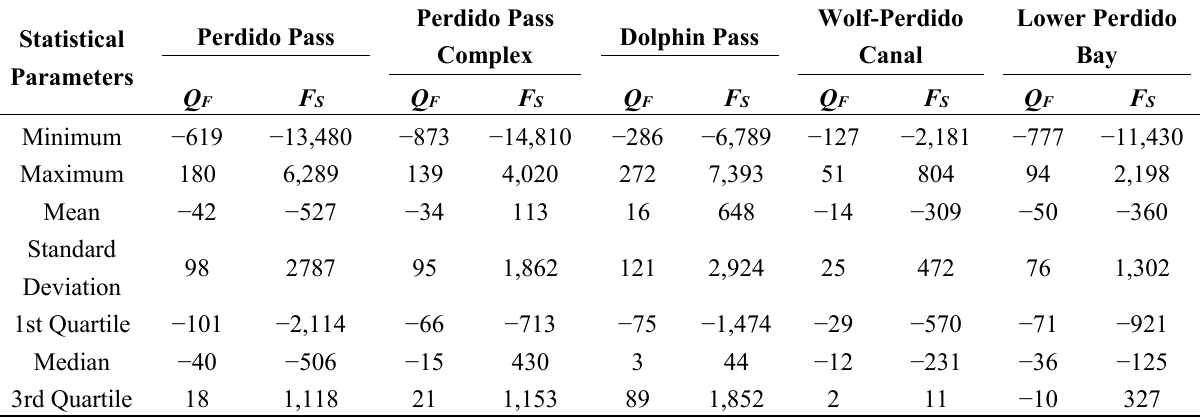
Figure 6. Shear dispersion ( F E ) and tidal oscillatory ( F T ) salt transport through four cross sections (Figure 1): ( a ) Perdido Pass complex (Section B-B); ( b ) Dolphin Pass (Section C-C); ( c ) Wolf-Perdido canal (Section D-D); and ( d ) Lower Perdido Bay (Section E-E). Table 3. Statistical summary of Q F (m 3 ·s − 1 ) and F S (kg·s − 1 ) computed using Eulerian decomposition method through five cross sections (Figure 1): Perdido Pass (Section A-A), the Perdido Pass complex (Section B-B), Dolphin Pass (Section C-C), the Wolf-Perdido canal (Section D-D), and lower Perdido Bay (Section